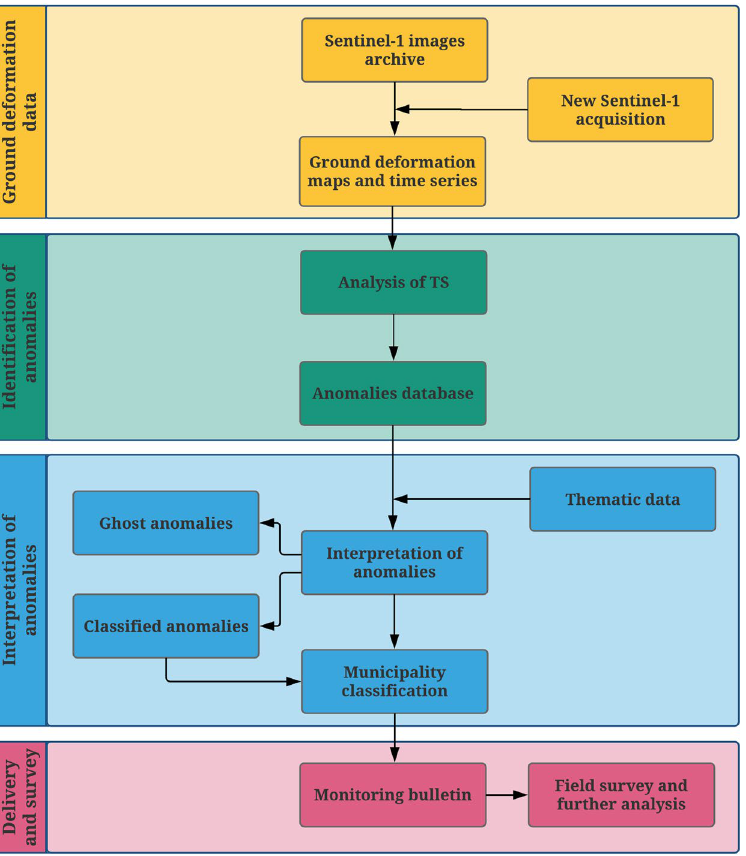
Figure 4. Flow chart of the methodology adopted in this monitoring service. As it becomes available, the new Sentinel-1 images is immediately downloaded and processed with the archive stack. TS are analysed with automatic tools for data mining and screening to identify anomalies. To ensure a timely delivery, anomalies are interpreted by a group of radar-interpreter within few hours from their identification.